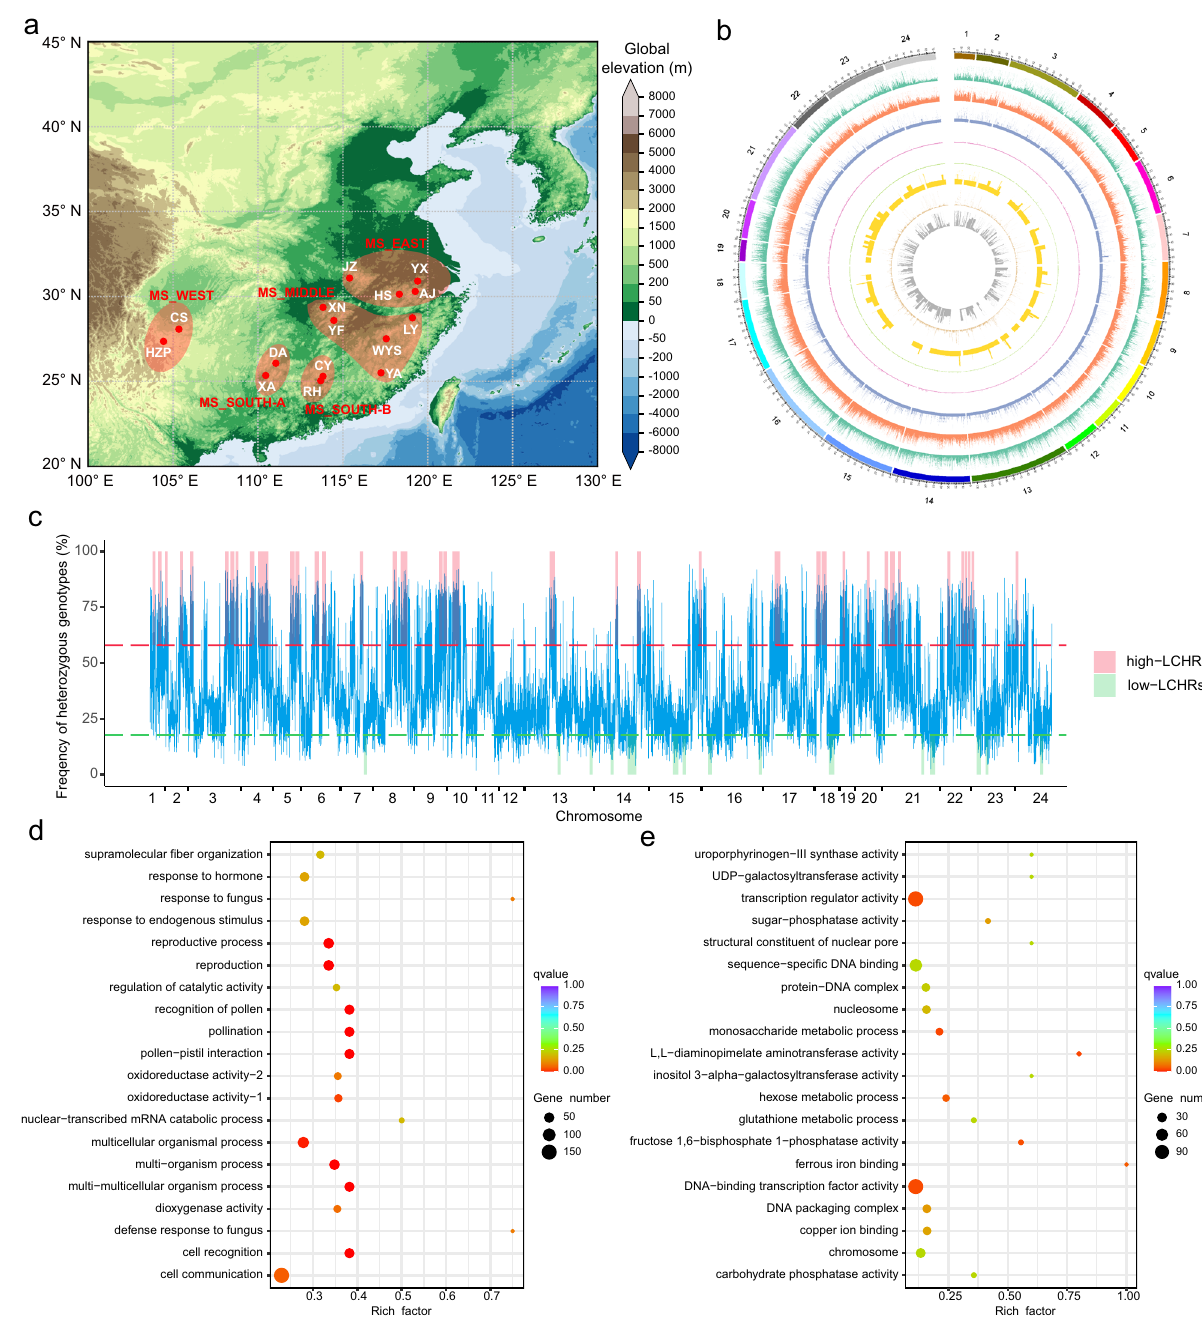
Fig. 1 The landscape of sampling and variants in sequenced moso bamboo individuals. a The sampling locations of 15 major moso bamboo geographic areas are indicated with red points, and fi ve empirically assigned phylogenetic groups according to the genetic structure and large-scale geographic distribution are represented in light shades. The map was drawn based on ETOPO2v2c Global Gridded 2-min elevation and bathymetric data (doi: 10.7289/V5J1012Q). b Circos plot for the visualization of different types of detected variants in the moso bamboo population at the genome-wide level. The tracks from outside to the inside represent the density of SNPs (single-nucleotide polymorphisms), InDels (small insertions and deletions), large deletions (DELs), insertions (INSs), inversions (INVs), intrachromosomal translocations (ITX), gained copy number variations (CNVs), and lost CNVs. Variant density was calculated in non-overlapping 100-kb window intervals. c Heterozygous genotype frequency in non-overlapping 200-kb windows genome wide. The red and green dashed lines represent the thresholds of high and low heterozygous genotype frequencies, respectively. The long continuous heterozygous SNPs clustered regions of high frequency (high-LCHRs) and long continuous heterozygous SNPs clustered regions of low frequency (low-LCHRs) are shaded in red and green, respectively. d The dot plot shows the gene ontology (GO) enrichment of genes located in high- LCHRs. e The dot plot shows the GO enrichment of genes located in low-LCHRs. The color of the points represents the Benjamini – Hochberg corrected p - value, and the size of points represents the number of genes. Rich factor is the ratio of the number of interested genes annotated in this GO term to all genes in this GO term. Source data underlying b – e are provided as a Source Data fi